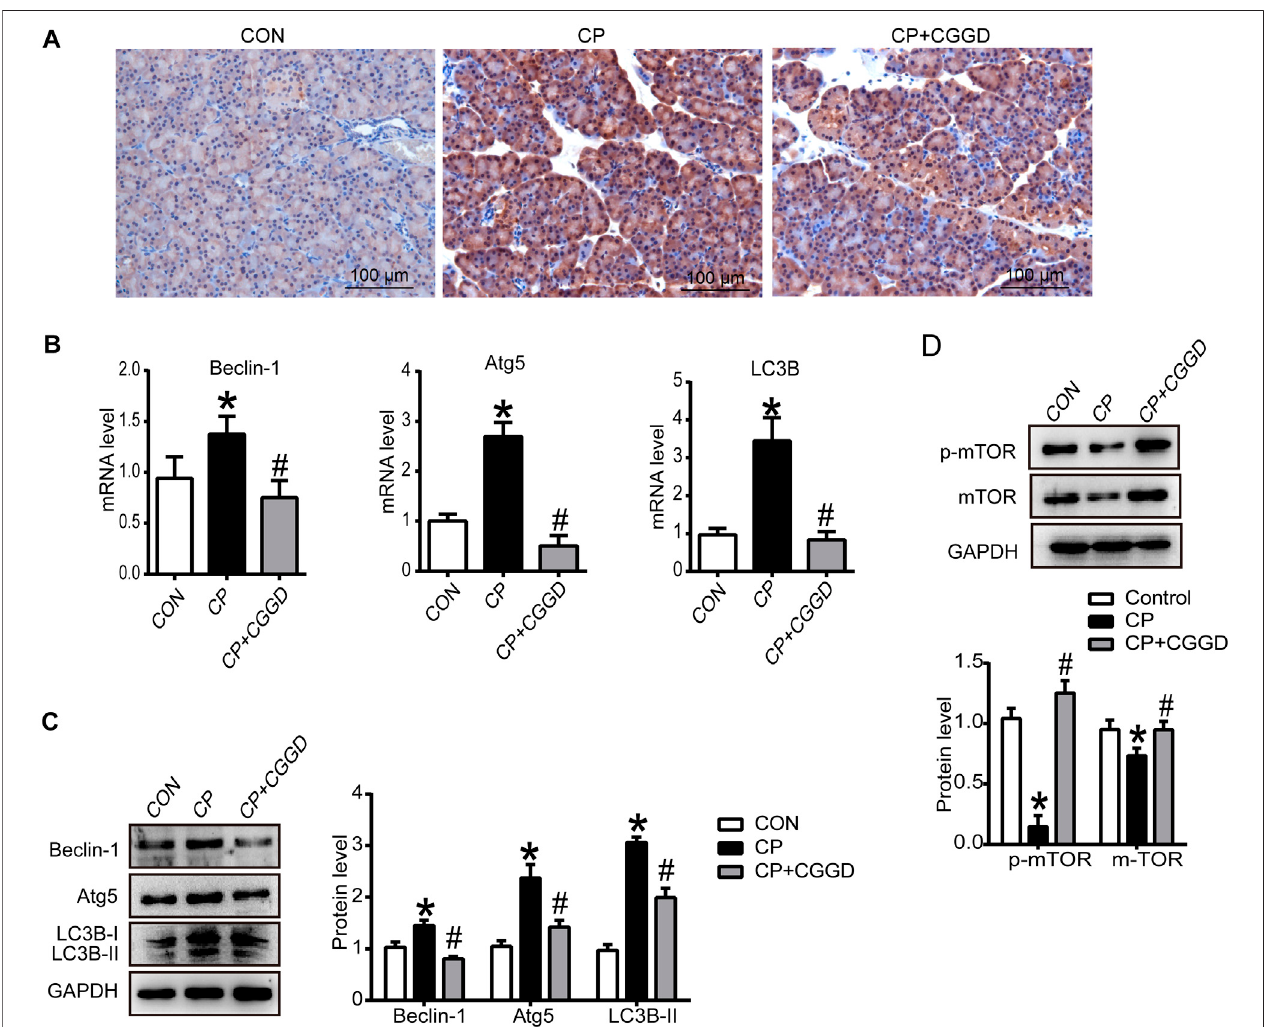
FIGURE 4 | In fl uence of CGGD on autophagy and the mTOR pathway in the pancreas. (A) Immunohistochemistry staining of LC3B (brown staining) in pancreatic tissues.Hematoxylinwasusedtocounterstainnuclei(originalmagni fi cation, × 200). (B) mRNAlevelsofBeclin-1,Atg5,andLC3BinthepancreasdetectedbyqRT-PCR. (C) Western blot analysis of Beclin-1, Atg5, and LC3B-I/II in the pancreas. (D) Western blot analysis of p -mTOR and mTOR in the pancreas. GAPDH was used as the loading control. Data are expressed as mean ± SD ( n (cid:2) 3). * p < 0.05 vs. control; # p < 0.05 vs.